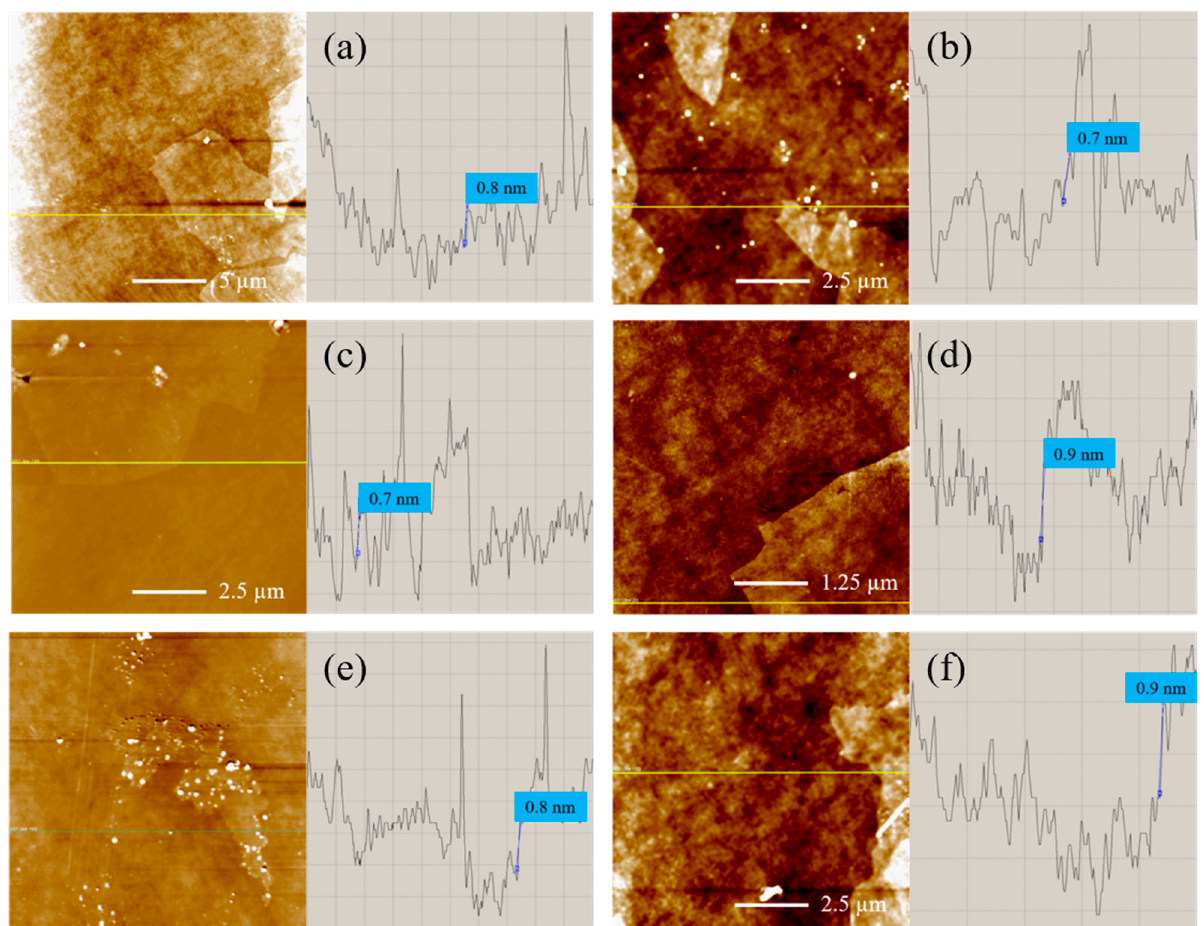
Figure 8. ( a – f ) AFM images and the corresponding height profiles of the MC#1–MC#6 GOs deposited onto the surface of silicon wafers, respectively.